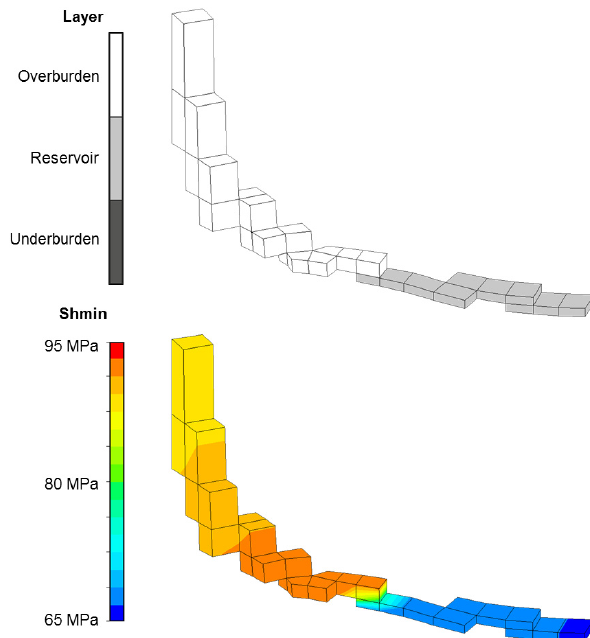
Fig. 3. Example of the selection of elements and modelling re- sults along the drilling path of a highly deviated well. Elements are coloured according to their layer (top) and magnitude of minimum horizontal stress (Shmin)